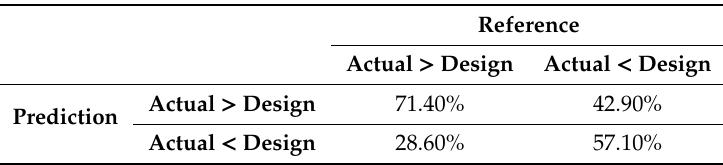
Table 2. Confusion matrix for random forest model prediction showing the percentage of correctly predicted tCOD concentration